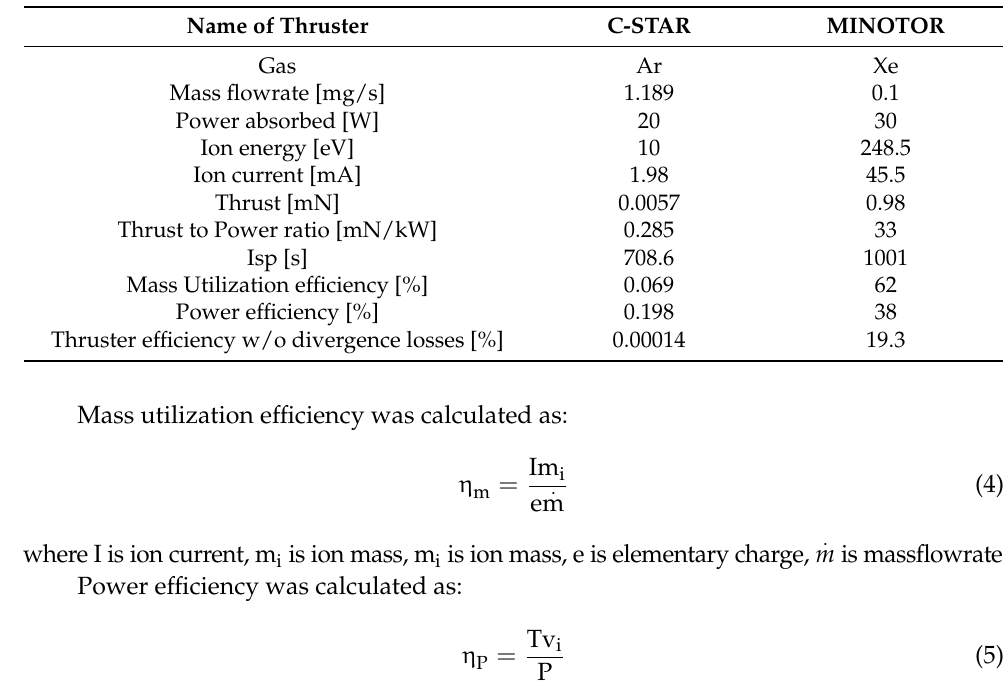
Table 1. Comparison of thruster parameters of C-STAR and MINOTOR